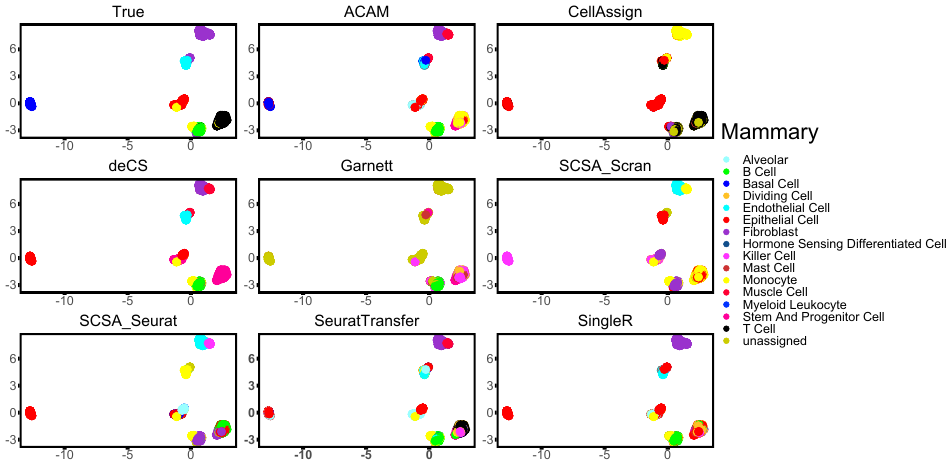
Figure 5. Two-dimensional visualization of the annotation results for dataset Mammary using UMAP.